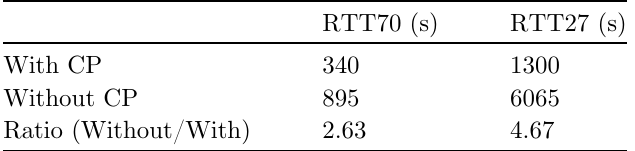
Fig. 3. Experimental temperature monitoring from TC1 with iso-thermal lines at 70 ° C and 27 ° C. Table 1. Return temperature time (RTT) in the module ’ s center for both cooling types. CP stands for Cooling